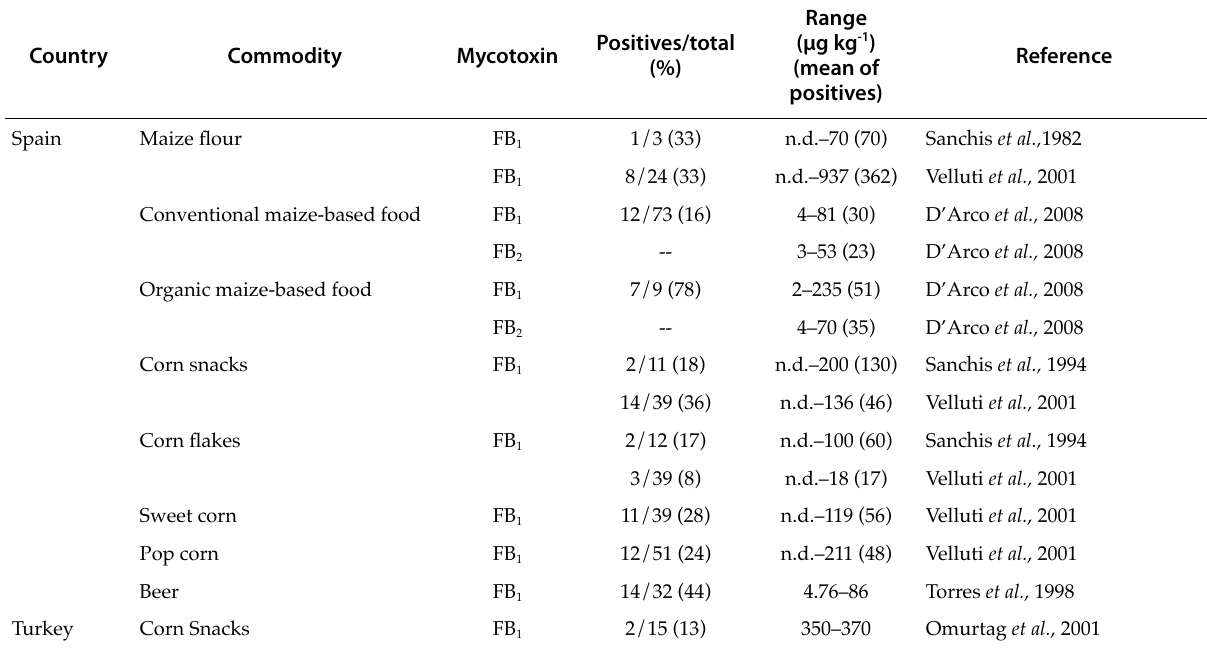
Table 9. Continues